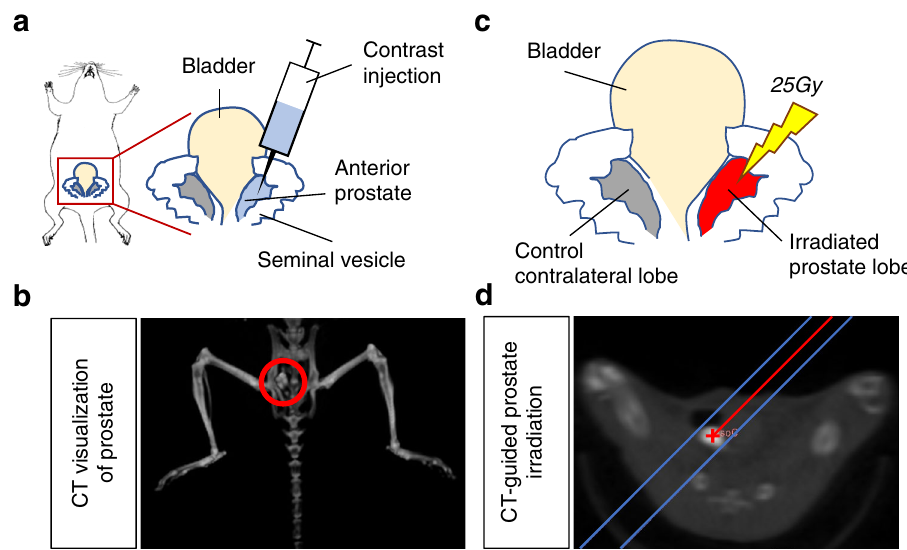
Figure 1. CT-guided stereotactic prostate radiation therapy (CT-SPRT) technique. ( a ) Diagram depicting intra- prostatic contrast injection to enable CT-visualization of the prostate ( b ; Left panel) and CT-guided targeting for X-ray irradiation of the prostate ( d ; Right panel); ( c ) Diagram depicting administration of a single fraction 25 Gy CT-targeted unilateral anterior prostate lobe X-ray radiation (CT-SPRT). Contralateral non-irradiated lobe acting as an internal